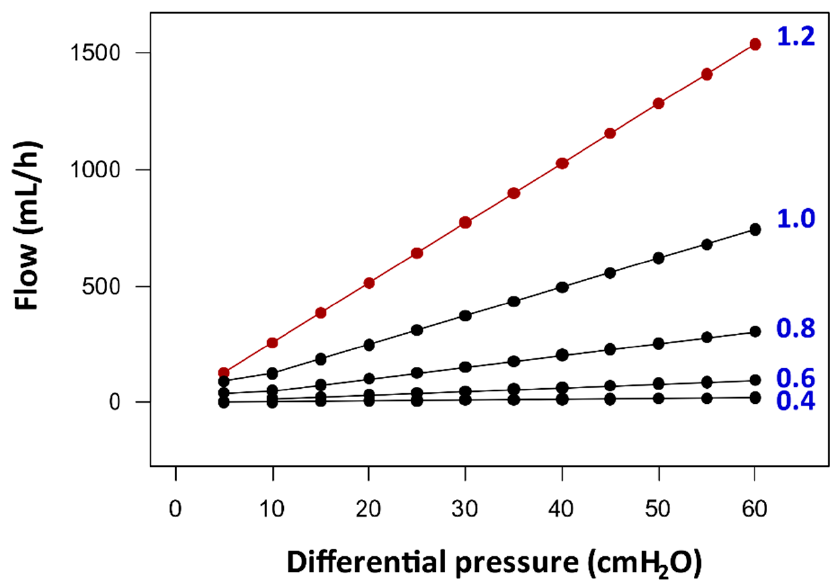
Figure 9. Estimated in vitro flow through silicon tubes of 100 cm constant length and with an inner diameter (ID) varying from 0.4 to 1.2 mm at different differential pressures (DPs) (0–60 cmH 2 O; 0–44 mmHg). The reader can replicate these data by using the online calculator provided by vCalc™ (http://bit.ly/2Y9FEss) and considering that the viscosity of water at a temperature of 37 °C is 0.69 mPa-s [48]. A tube with an ID of 1.2 mm has a theoretical R shunt of 1.72 mmHg/mL/min, of 2.43 mmHg/mL/min when the ID is decreased to 1.1, and of 139 mmHg/mL/min when the ID is 0.40 mm. At a DP of 60 cmH 2 O, the maximum flow for each tube will increase from 19 mL/h for a tube with an ID of 0.4 to 1539 mL/h for a tube with an ID of 1.2 mm. The reader needs to be aware that theoretical estimates in R shunt reported here can differ from some published results on bench tests. Theoretical estimates may differ from results on tubes conducted in test rigs because of differences in the catheter length, presence of air bubbles, experimental temperature, composition of the infused fluid, and characteristics of the flow (pulsatile vs.